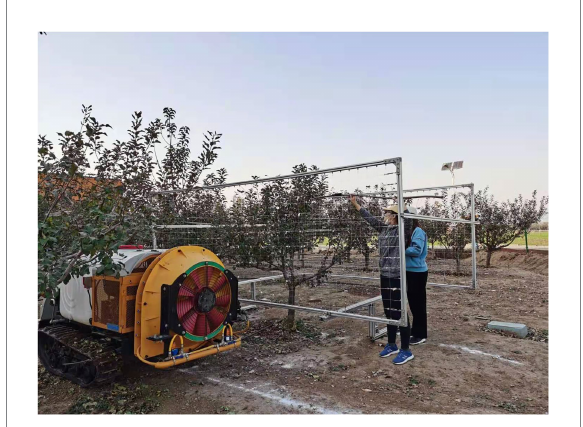
FIGURE 5 Airflow measurement in the canopy.